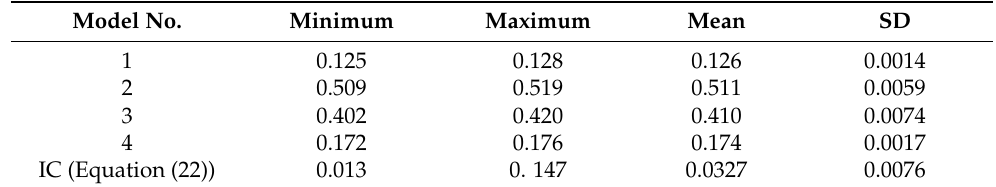
Table 11. SDR ranges for the five models used in the DLB for the period between 1961 and 2008. Model